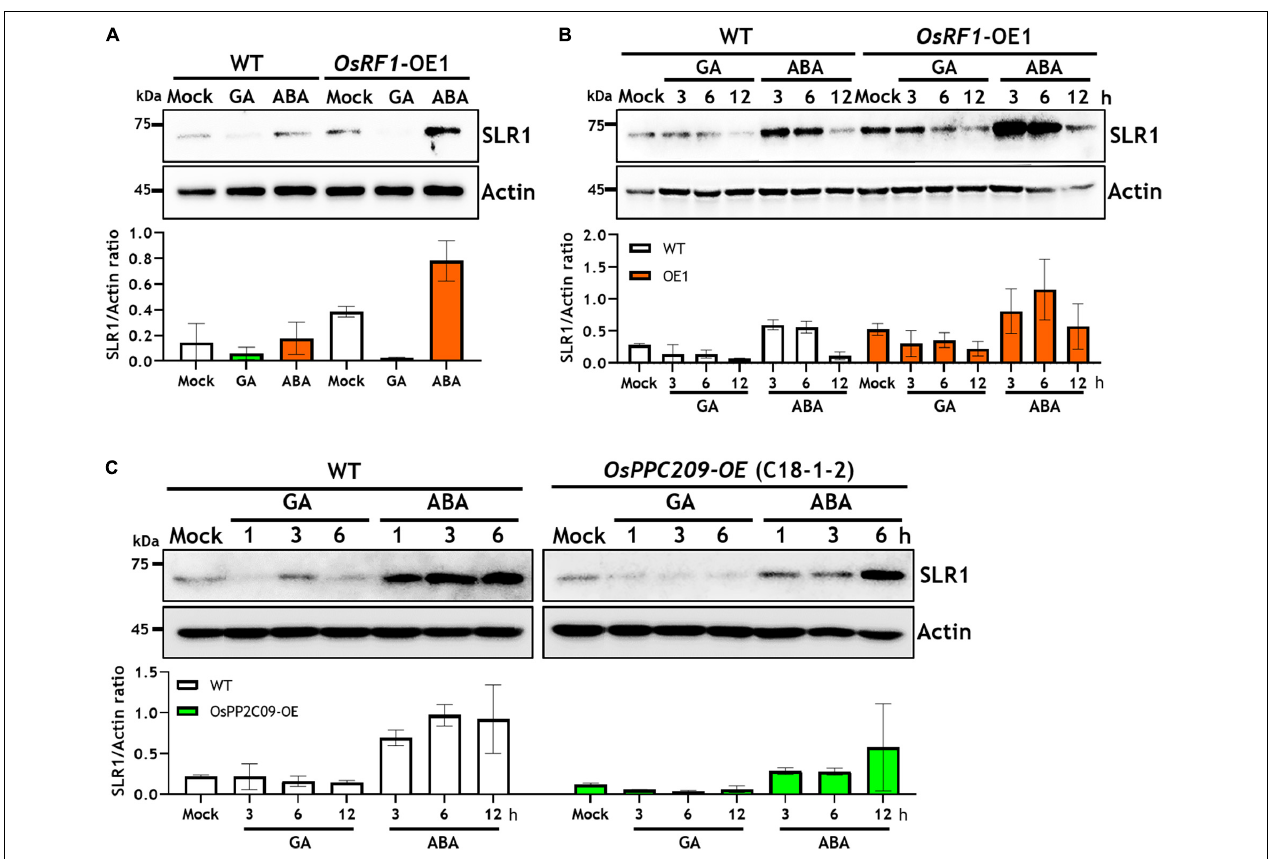
FIGURE 7 | Overexpression of OsRF1 and OsPP2C09 affects the stability of Slender1 (SLR1) protein. (A) Protein level of endogenous SLR1 in WT and OsRF1 -OE rice seedlings grown for 7 days in 1/2 MS agar media containing 50 µ M GA 3 or 50 µ M ABA. (B) Protein stability of SLR1 in WT and OsRF1 -OE rice in response to GA 3 or ABA treatment. Seven-day-old seedlings exposed for 3 to 12 h in the presence of 50 µ M GA 3 or 50 µ M ABA. (C) Protein stability of SLR1 in WT and OsPP2C09 -OE rice in response to GA 3 or ABA treatment. Seven-day-old seedlings were exposed for 1 to 6 h in the presence of 5 µ M GA 3 or 50 µ M ABA. A total of 30 µ g of whole protein extracts from rice shoots were dissolved in 10% SDS-PAGE and immunoblotted using anti-SLR1 antibody. Rice actin protein was used as loading control determined by immunoblotting using anti-Actin antibody. Quantification of anti-SLR1 and anti-actin signal intensity using the Image J software. SLR1 protein levels were normalized by anti-actin intensity. Data represent mean ( ± SD) from two independent experiments with three biological replicates ( n =